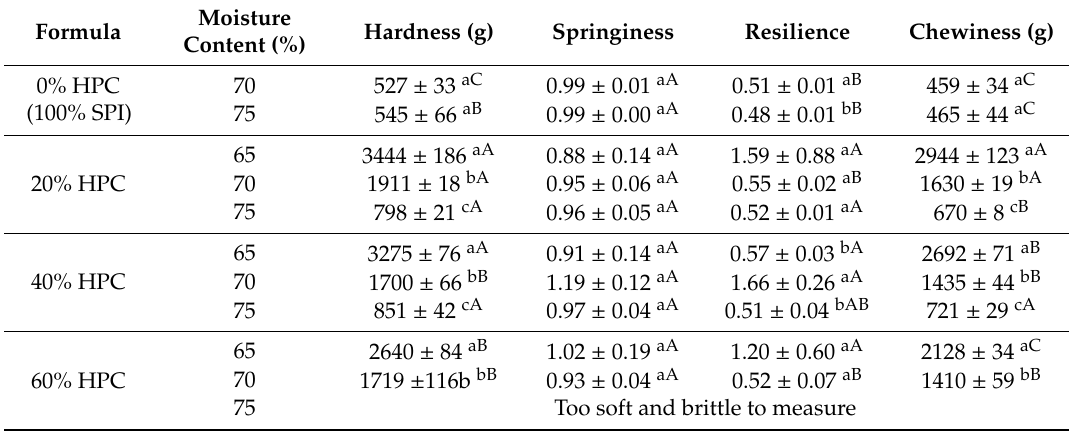
Table 3. Texture profile analysis result of HMMA at di ff erent formulations and target moisture content 1